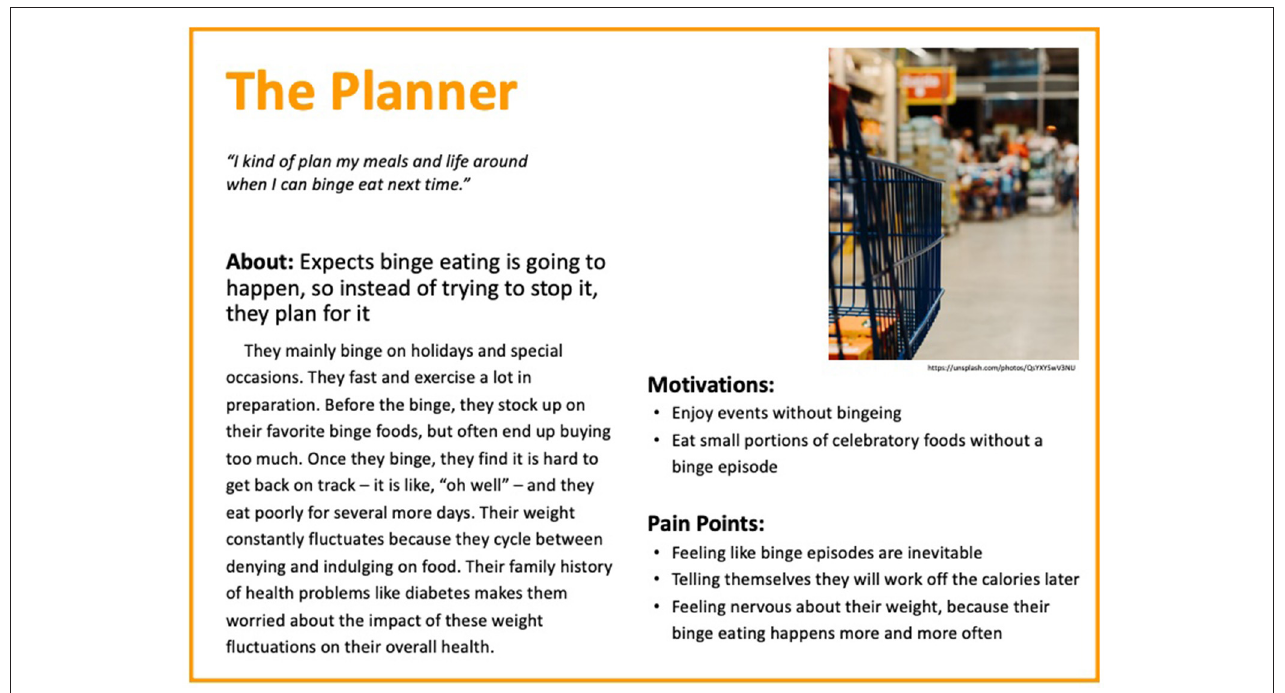
FIGURE 5 | Persona 5: The